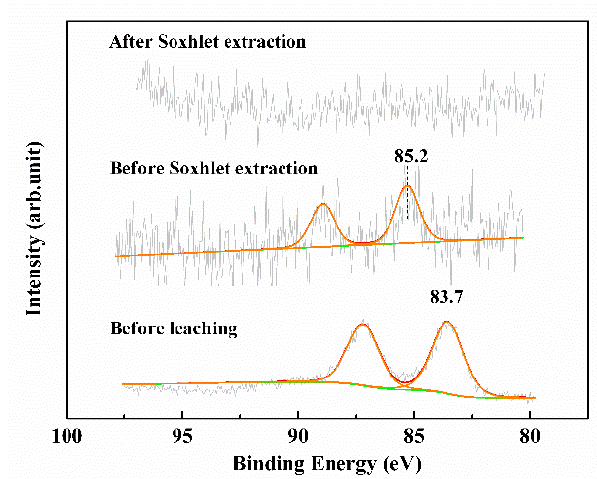
Figure 10. XPS spectra of catalysts in different stages.